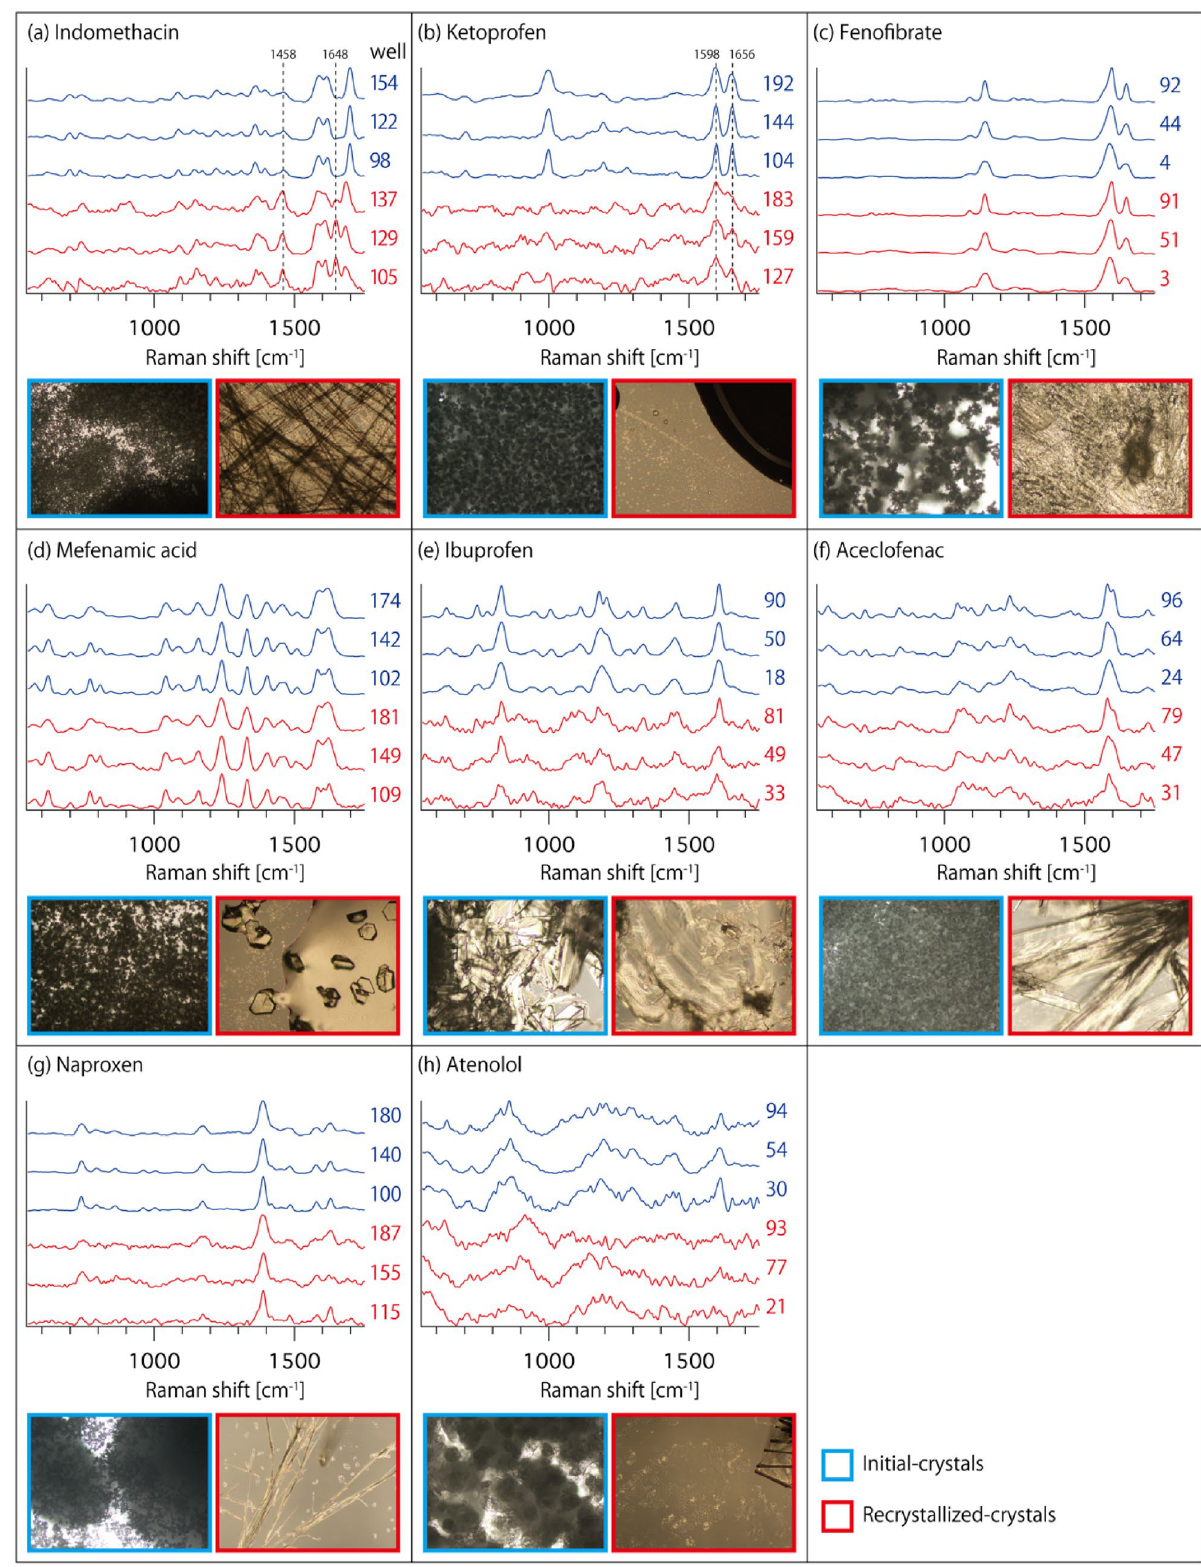
Figure 2. Representative Raman spectrum of drug crystals in wells for the investigation of drug polymorphism. ( a ) Indomethacin, ( b ) ketoprofen, ( c ) fenofibrate, ( d ) mefenamic acid, ( e ) ibuprofen, ( f ) aceclofenac, ( g ) naproxen, and ( h ) atenolol. Raman spectra of initial and recrystallized crystals are shown in blue and red, respectively. Each spectrum is normalized in intensity. Representative microscopic images of crystals are also shown for each drug molecule. The image size is 1.4 × 1.0 mm 2